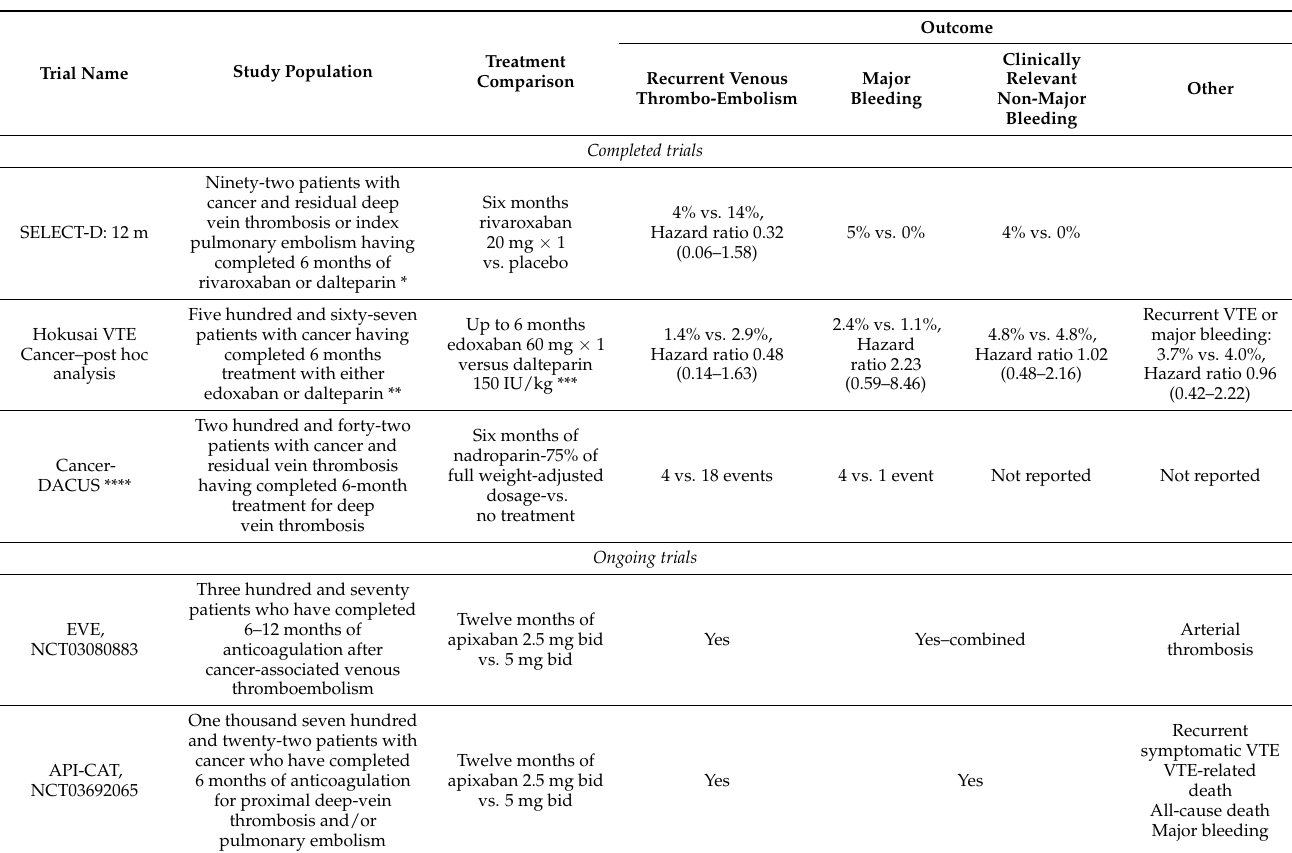
Table 2. Overview of randomized trials investigating the effectiveness and safety of anticoagulation beyond 6 months treatment in patients with cancer and venous